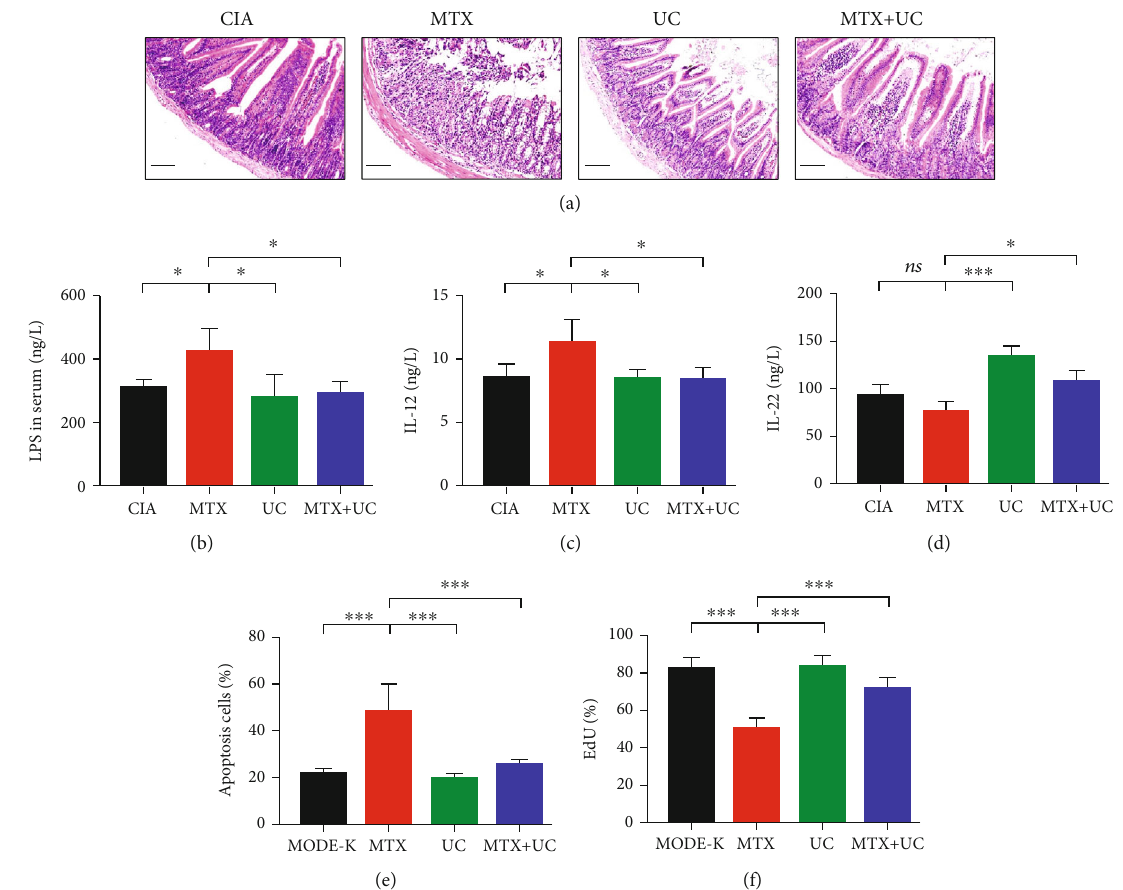
Figure 3: Combination of UCs and MTX ameliorated side e ff ects of MTX. (a) Representative images of H&E staining of intestinal sections of four groups. Combined application of MTX and UCs to CIA mice downregulated the content of LPS (b) and IL-12 (c) in serum compared to CIA mice treated by MTX. (d) Using UCs or combination of MTX and UCs to treat CIA mice promoted the expression of IL-22 in serum compared to CIA mice treated by MTX. (e) Apoptosis of MODE-K treated by MTX and cocultured with UCs was analyzed by fl ow cytometry. (f) Proliferation of MODE-K treated by MTX and cultured with UCs was assessed by EdU analysis. Scale bar, 100 μ m. n = 4 ‐ 6 per group. Data are shown as mean ± SD . ∗ P < 0 : 05 ; ∗∗ P < 0 : 01 ; ∗∗∗ P < 0 : 001 ; ns: not signi fi cant ( P > 0 : 05